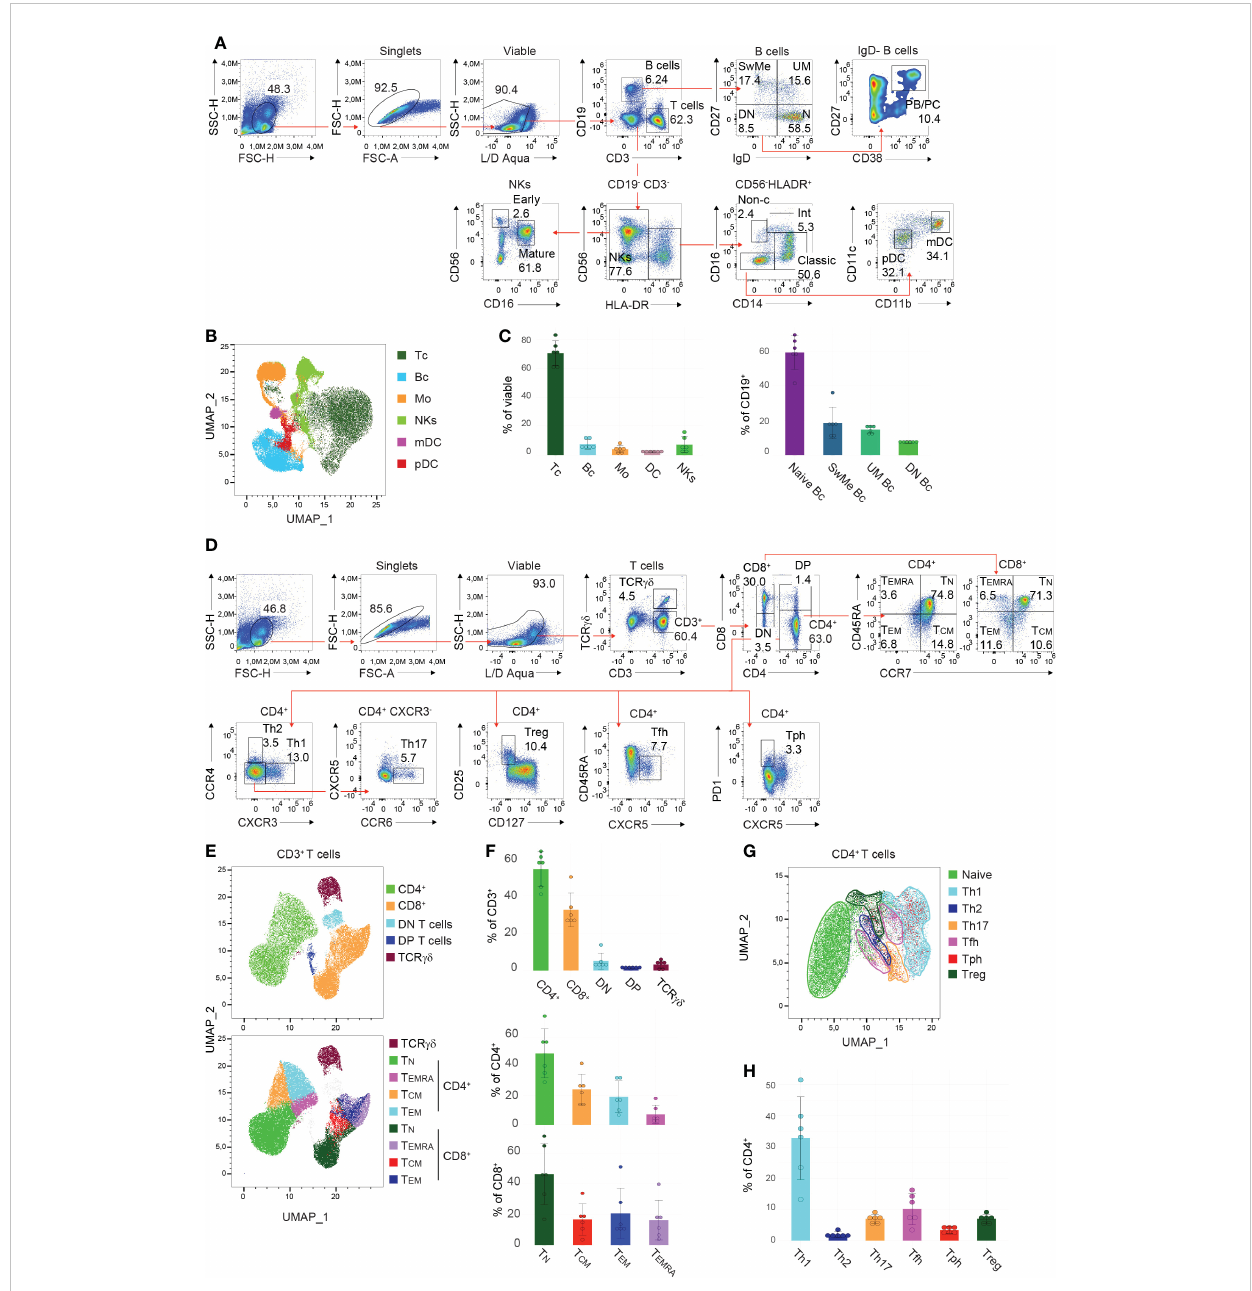
FIGURE 2 Gating strategy and presentation of PBMC and T cell subsets (A, D) Manual gating approaches of the major (A) PBMC subsets and (D) T cell subsets, respectively, following 24 hours of in vitro cultivation. Red arrows depict the relationships across plots. Numbers indicate the percentages of cells in the quadrants or gates. Individual parent gates are referred to on top of the plots when necessary. One representative donor is shown. (B, E, G) High-dimensional data analysis using Uniform Manifold Approximation and Projection (UMAP) trained on (B) whole PBMCs, (E) CD3 + T cells, and (G) CD4 + T cells, respectively, of concatenated donors depicting the accurate separation of the manually gated subsets following 24 hours in vitro cultivation. UMAPs were generated in FlowJo. (C, F, H) Bar charts illustrating the percentages of indicated subsets within (C) viable PBMCs